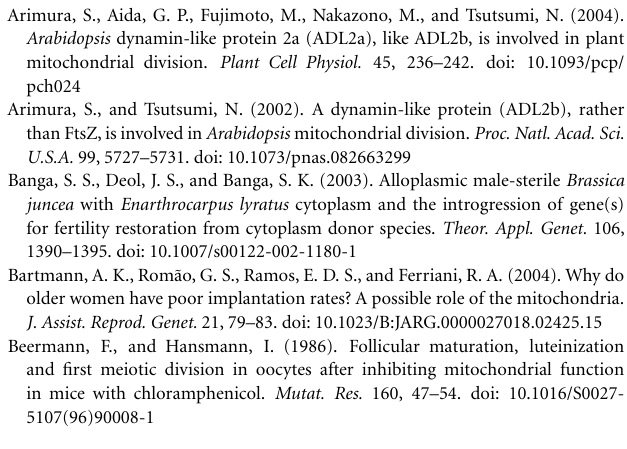
examples of alloplasmic plants and the influence of cytoplasm on development. The first and third pictures are examples of cytoplasmic influence on vigor, middle figure is the influence on fertility and the two right most figures (both top and bottom) illustrate the influence of a single nuclear locus ( species cytoplasm specific or scs ) on seed and plant development in alloplasmic condition. In all cases A = alloplasmic and E =